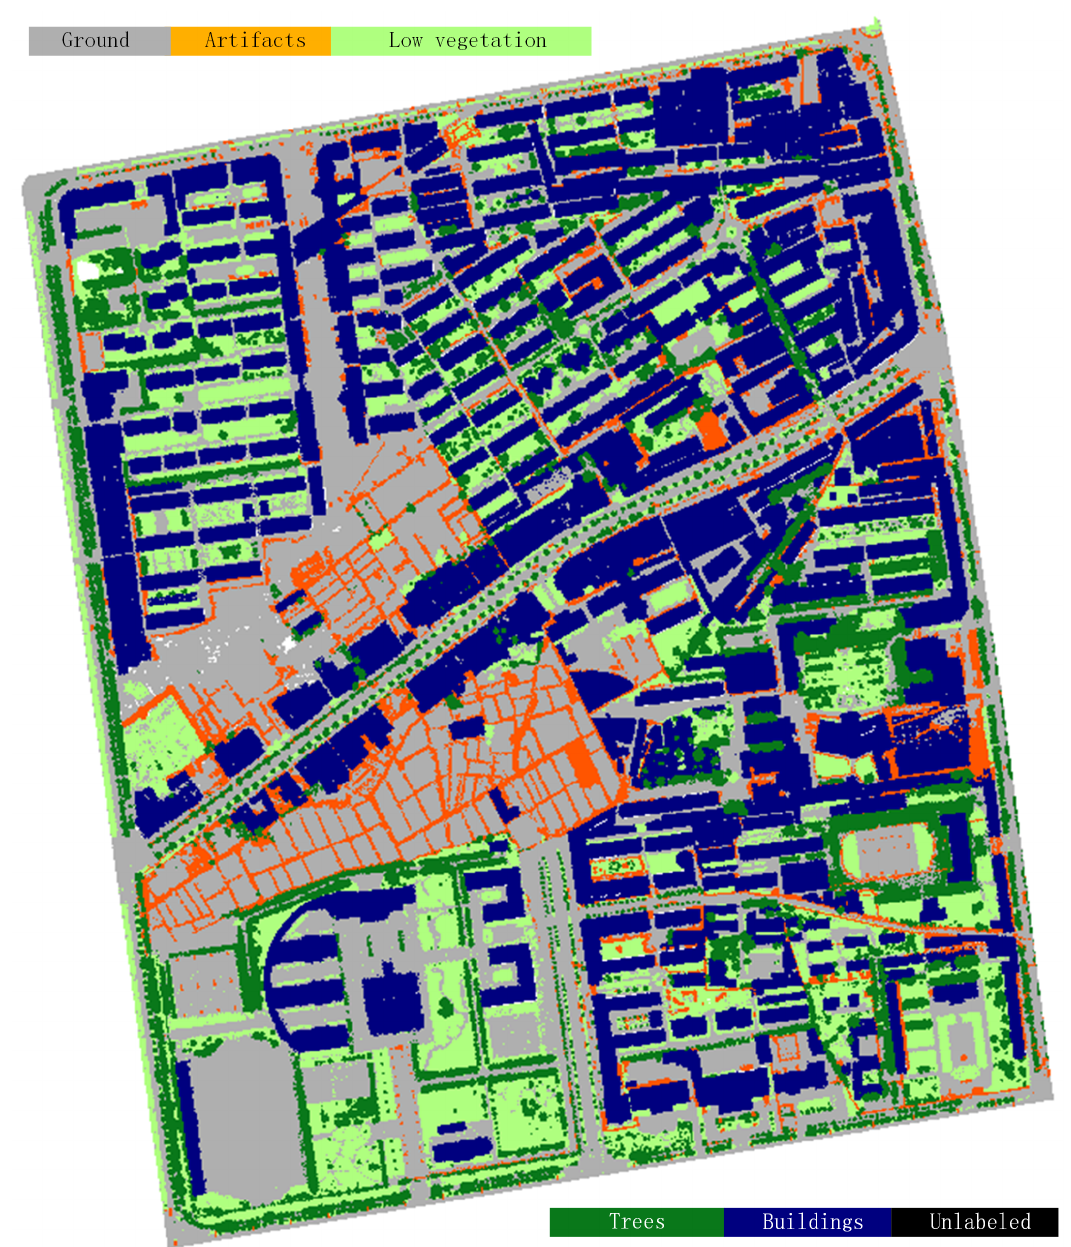
Figure 7. Annotated dataset with points of different labels rendered with different